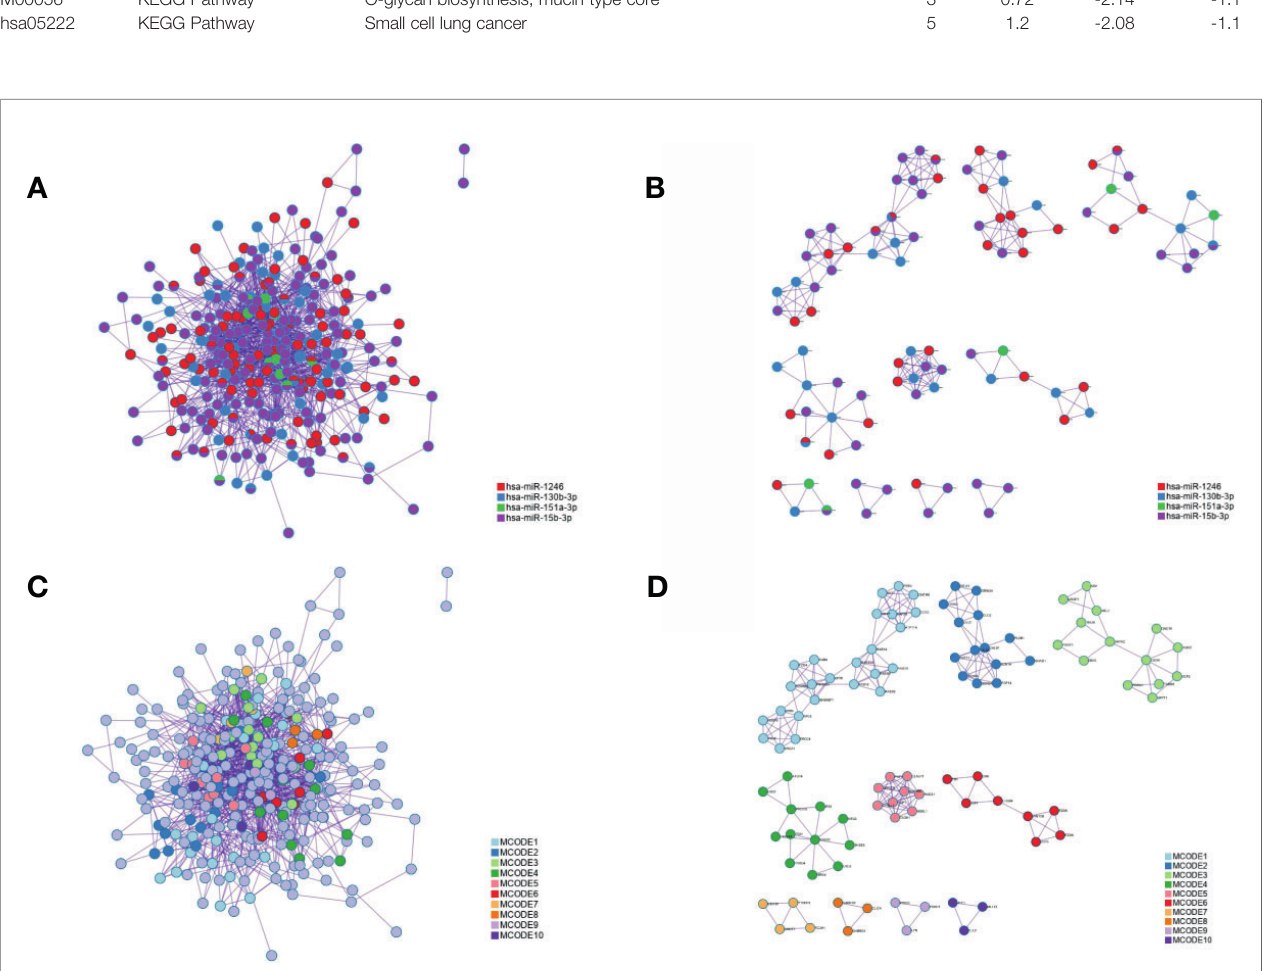
FIGURE 7 | The protein-protein interaction (PPI) network of all common targets. (A) Network colored by DEmiRNAs group. (B) MCODE subnetworks colored by DEmiRNAs group. (C) Network colored by MCODE clusters. (D) MCODE subnetworks colored by MCODE